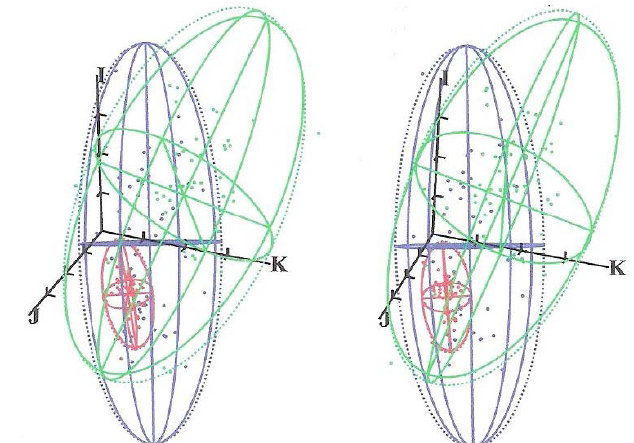
Figure 7: Stereo-pair scatter plot of fifty measurements of refractive state taken from subject 6. The origin of the axes is at 0.5 I D.